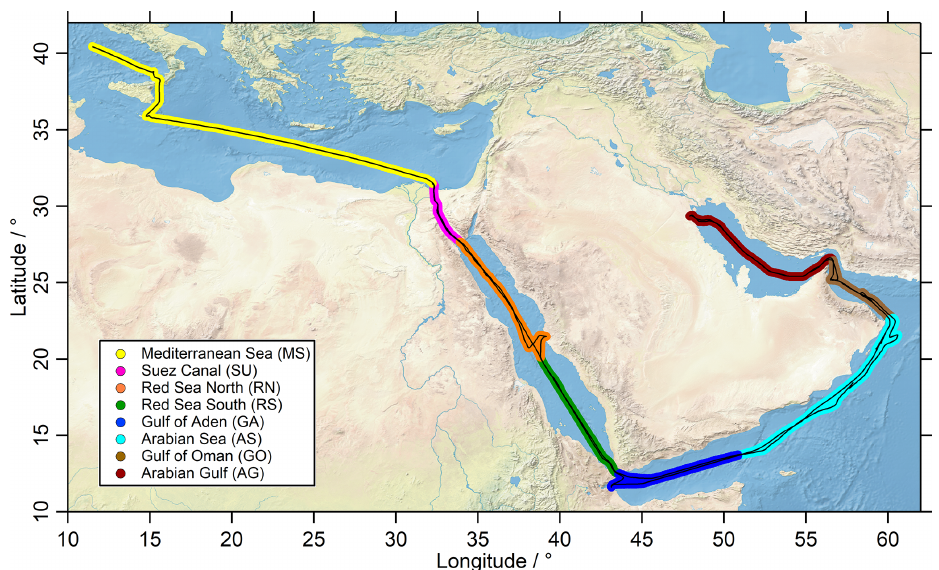
Figure 1. The ship route (black) of the Kommandor Iona during the AQABA cruise subdivided into eight regions: Mediterranean Sea (MS: yellow), Suez Canal (SU: pink), Red Sea north (RN: orange), Red Sea south (RS: green), Gulf of Aden (GA: blue), Arabian Sea (AS: turquoise), Gulf of Oman (GO: brown) and Arabian Gulf (AG: